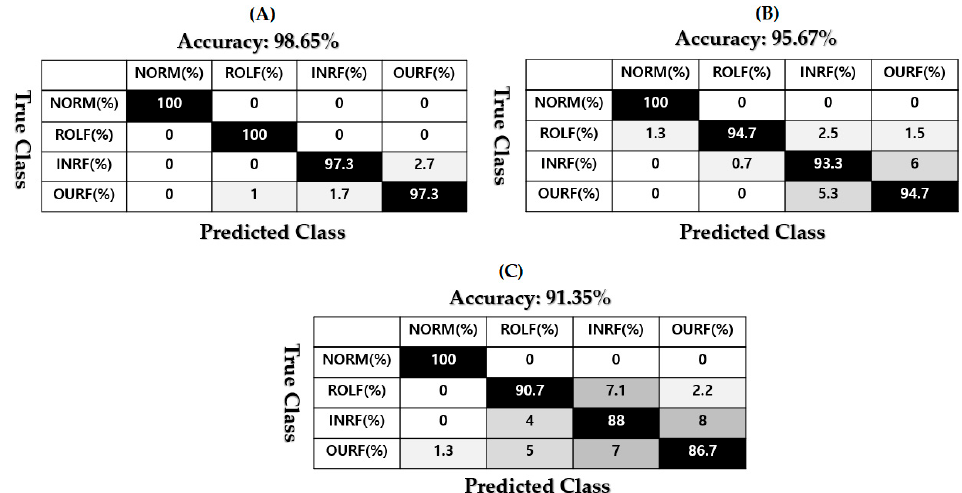
Figure 10. The average fault identification accuracy based on ( A ) the proposed AMRXU- AVSPMI+SVM, ( B ) AMRXU-VSPMI+SVM, and ( C ) AMRXU-PMI+SVM (torque load: 1 hp). Figure 9. The average fault identification accuracy based on ( A ) the proposed AMRXU-AVSPMI+SVM, ( B ) AMRXU-VSPMI+SVM, and ( C ) AMRXU-PMI+SVM (torque load: 0 hp).